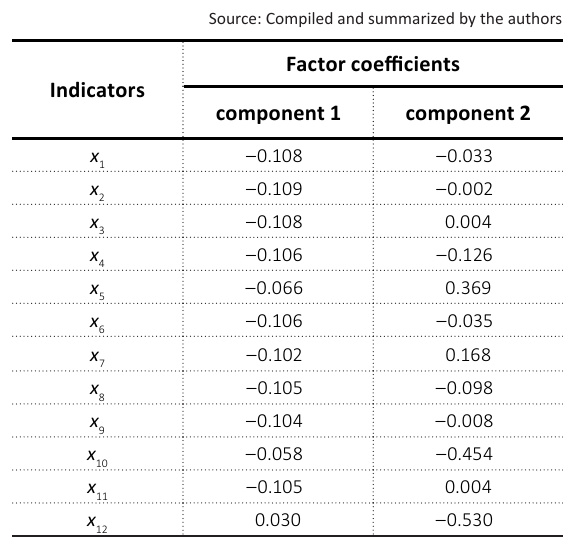
Table 8. The matrix of factor coefficients